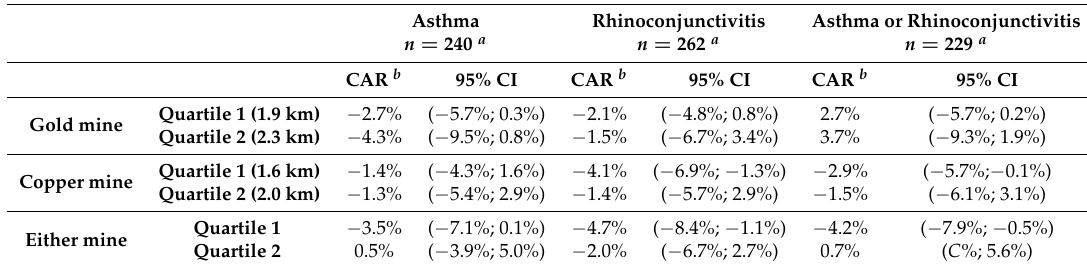
Table 3. Estimated causal attributable risk (CAR) of respiratory diseases in children, expressed as percentage points with the 95% confidence intervals (95% CI). Data from children living in a rural mining community in the north of Chile, 2009.